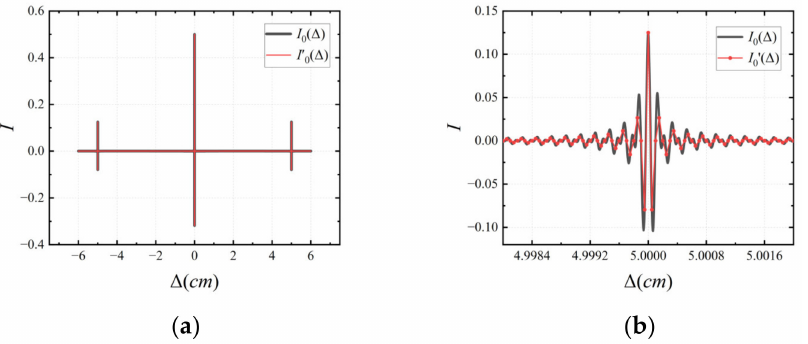
Figure 7. ( a ) The interferogram when the input spectrum is a cosine function; ( b ) the partial magnifi- cation comparison of this